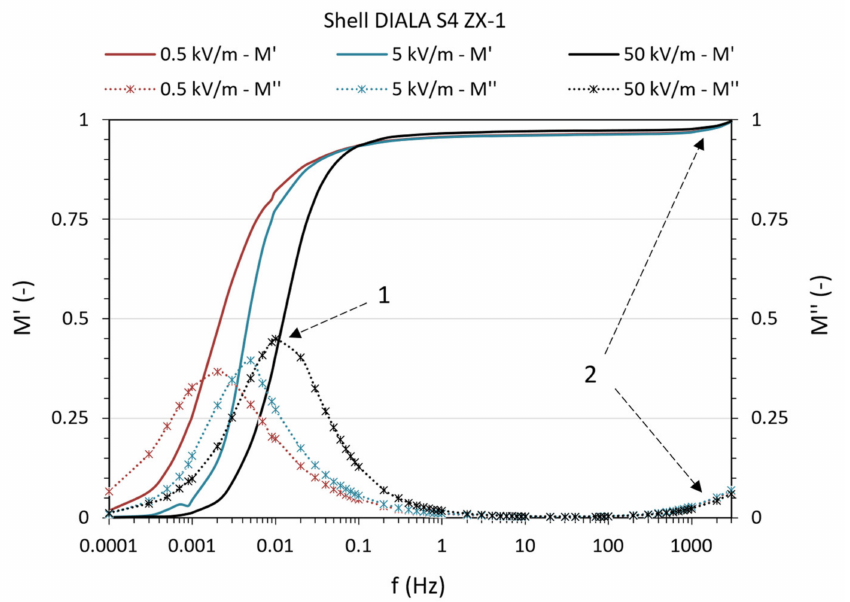
Figure 5. Complex electric modulus M* of SD oil in the frequency